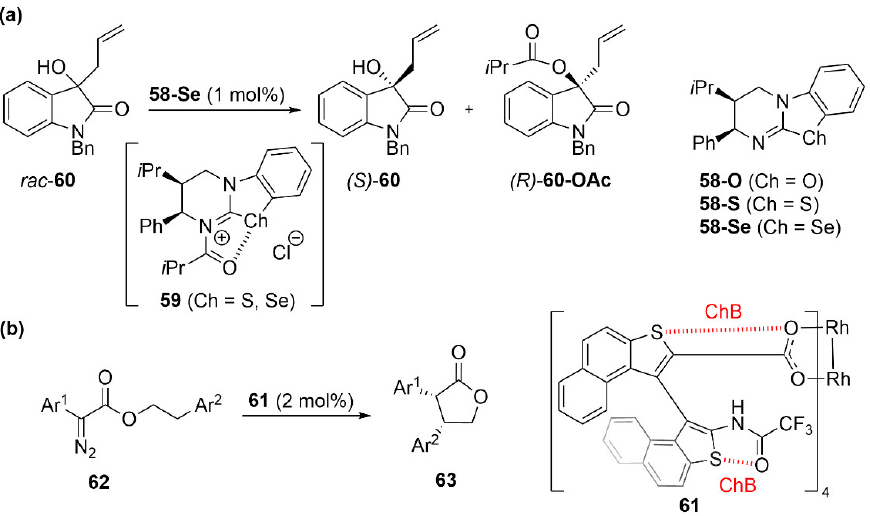
Figure 24. Stabilization of intermediate or catalyst through ChB in asymmetric reactions: ( a ) kinetic resolution of tertiary alcohols and ( b ) intramolecular C−H insertion into α-aryl-α-diazoacetates.